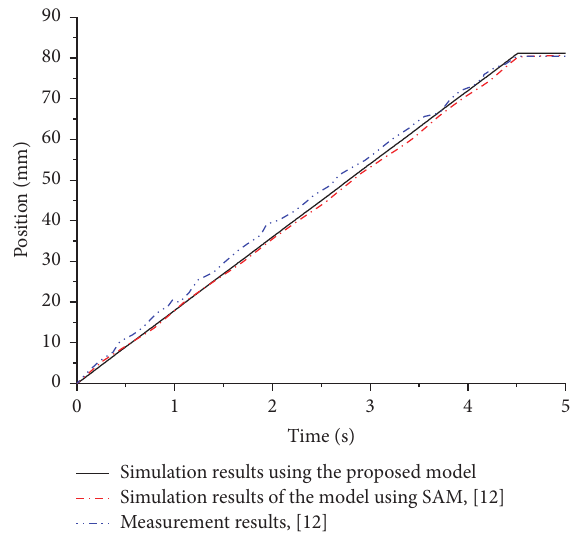
Figure 9: Transient characteristic of the mover position under no- load for ] = 18 mm/s.